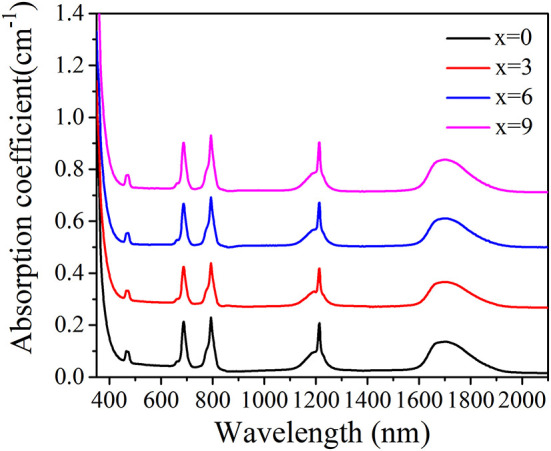
Absorption spectra in TGB glasses with different BaF2 contents.